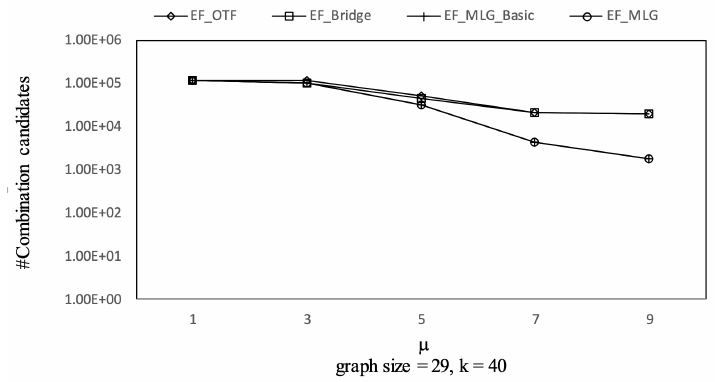
Figure 24. Combinations pruning on Ncfu vs. µ with graphsize = 29 and k = 40.